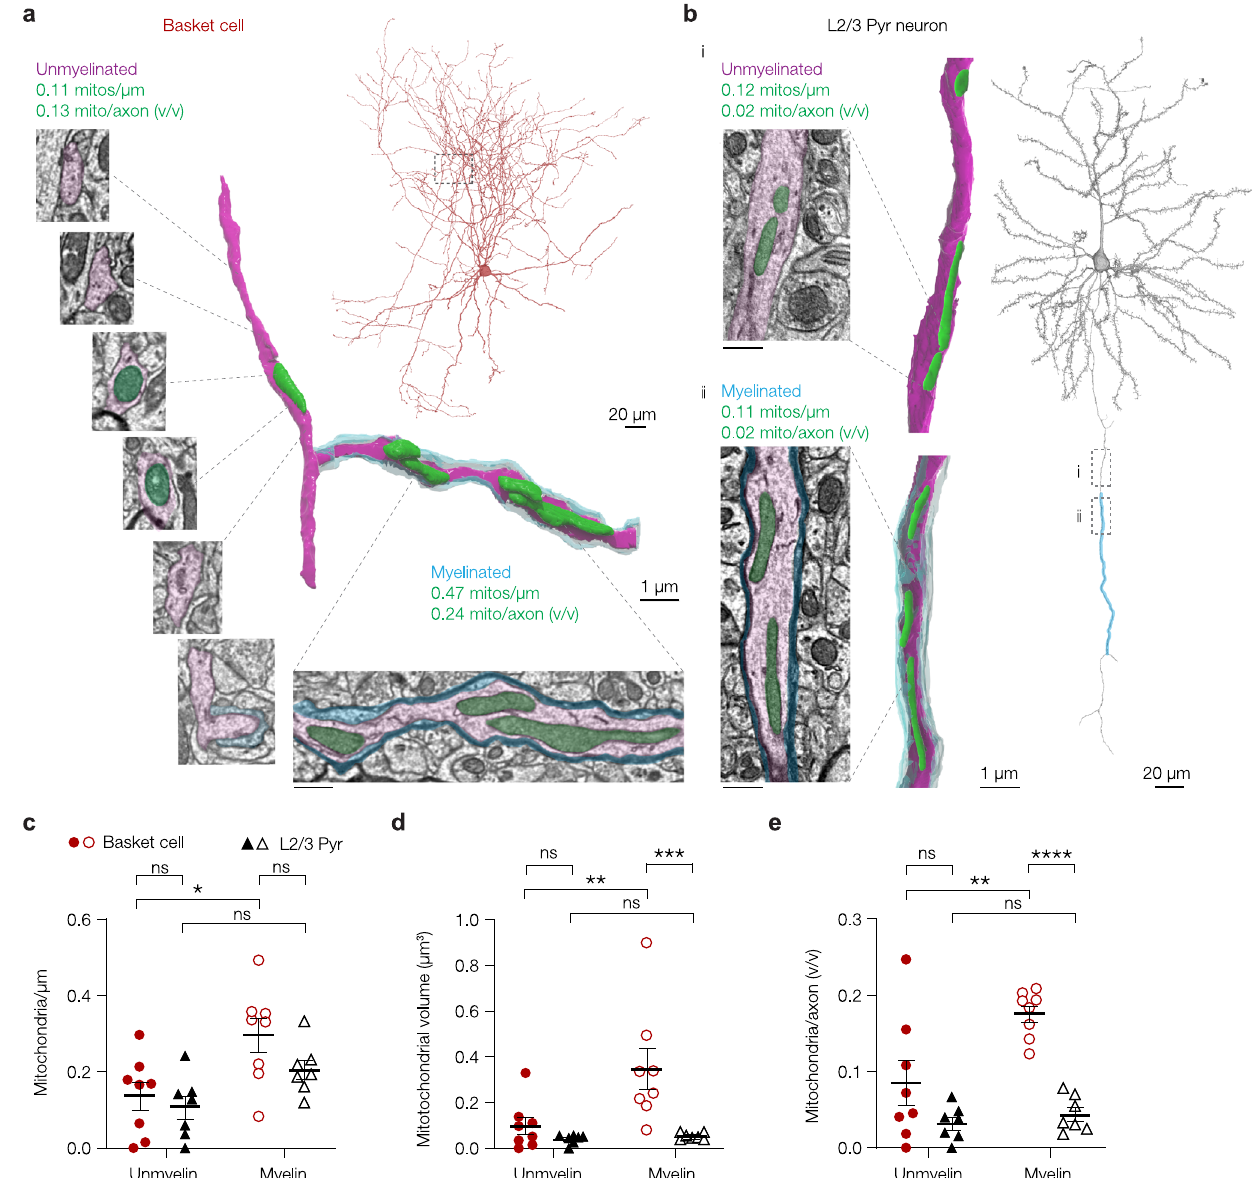
Fig. 5 | Myelination assembles mitochondria in basket cell- but not PN inter- nodes. a , b 3D EMrenders and reconstructions of a basket cell ( a ) and L2/3 PN ( b ) axonwithandwithoutmyelin.Similarresultswereobtainedin8basketcellsand7 L2/3PNs. c MitochondrialdensityisincreasedinmyelinatedbasketbutnotL2/3PN segments (two-way ANOVA, myelination x cell type effect, P =0.4162, F (1,13) = 0.7052; myelination effect, P =0.0034, F (1,13) = 12.82; cell type effect, P =0.1206, F (1,13) = 2.760;Bonferroni ’ s post hoctest, basket myelin. vs. unmyelin., * P =0.0130; PN myelin. vs. unmyelin., P =0.1665; Myelin. basket vs PN, P =0.1766; Unmyelin. basket vs PN P >0.9999). d Mitochondria in basket myelinated axonal segments are larger compared to those in PNs (two-way ANOVA, myelination x cell type effect, P =0.0430, F (1,13) = 5.028; myelination effect, P =0.0285, F (1,13) = 6.070; cell type effect, P =0.0043, F (1,13) = 11.89; Bonferroni ’ s post hoc test, basket myelin. vs. unmyelin.,** P =0.0087;PNmyelin.vs.unmyelin., P >0.9999;Myelin.basketvsPN, *** P =0.0009;Unmyelin.basketvsPN P =0.9090;basket,myelin. n